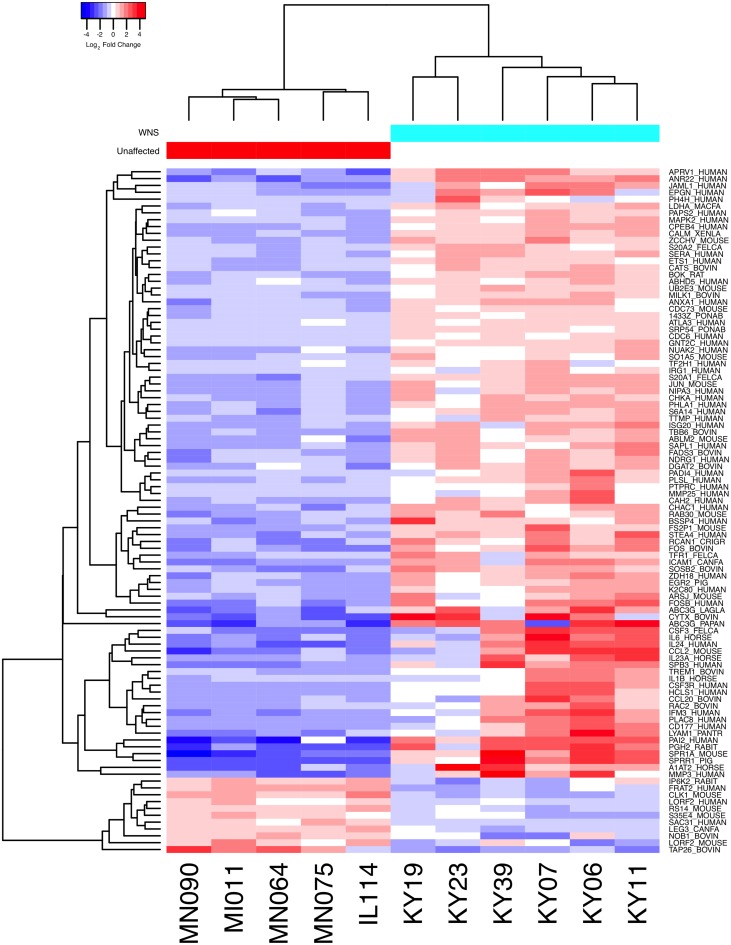
Global transcriptional analysis of WNS-affected and unaffected bats by RNA-Seq.Centered log2 fold changes are shown for the 100 most significant differentially expressed identified genes. Adjusted p values ranged from 3.3x10-5 to 2.8x10-18. The heatmap of TMM-normalized FPKM expression estimates is centered and log2 scaled from a minimum of -4.8 to a maximum of 4.8. Transcripts were identified by BLAST alignment to the SwissProt database.